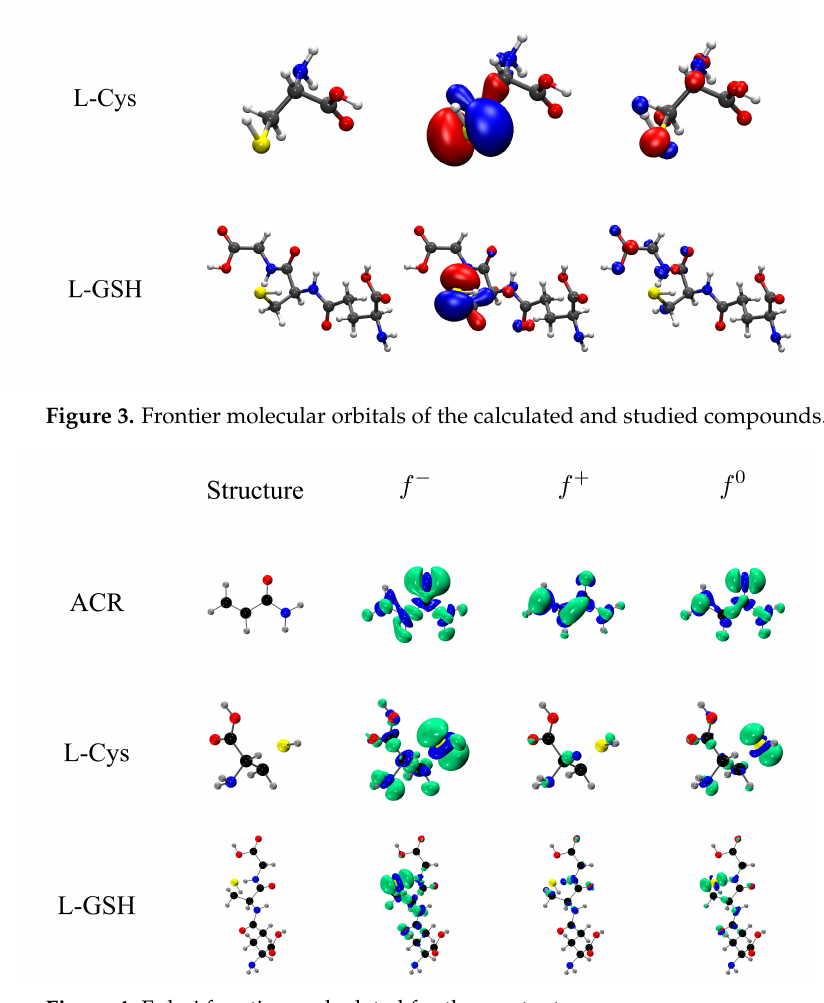
Figure 4. Fukui functions calculated for the